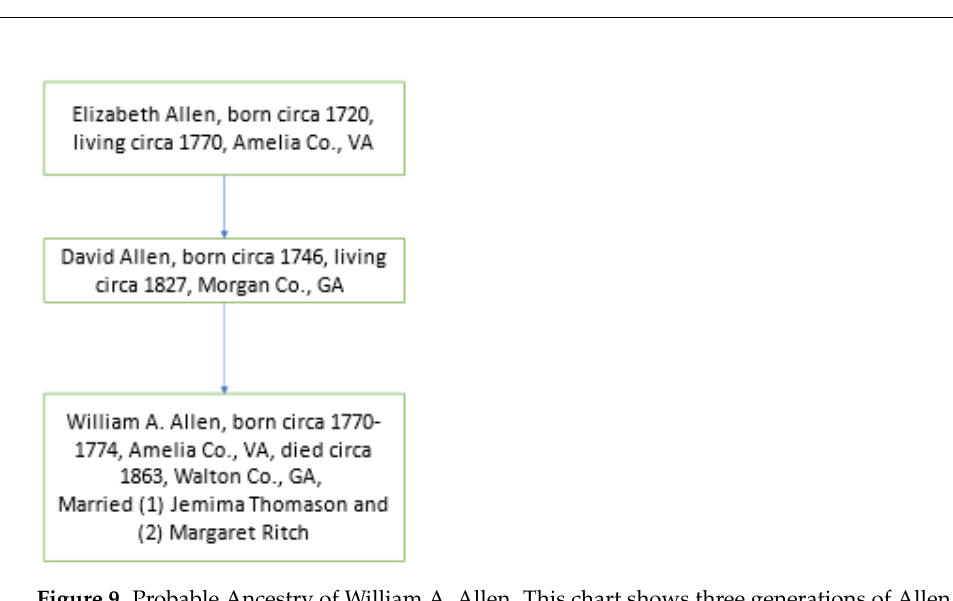
Figure 9. Probable Ancestry of William A. Allen. This chart shows three generations of Allen family relationships as reconstructed in this